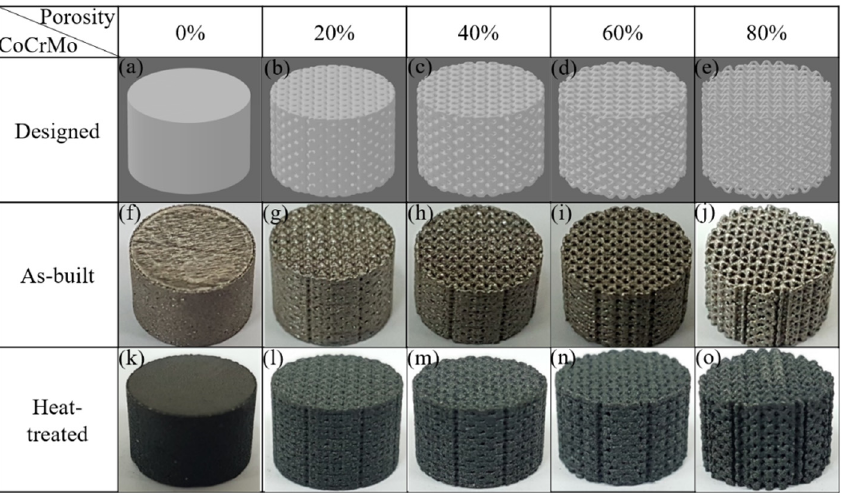
Figure 1. ( a – e ) CAD-designed models, ( f – j ) as-built, and ( k – o ) heat-treated CoCrMo alloys with different, designed volume porosities.